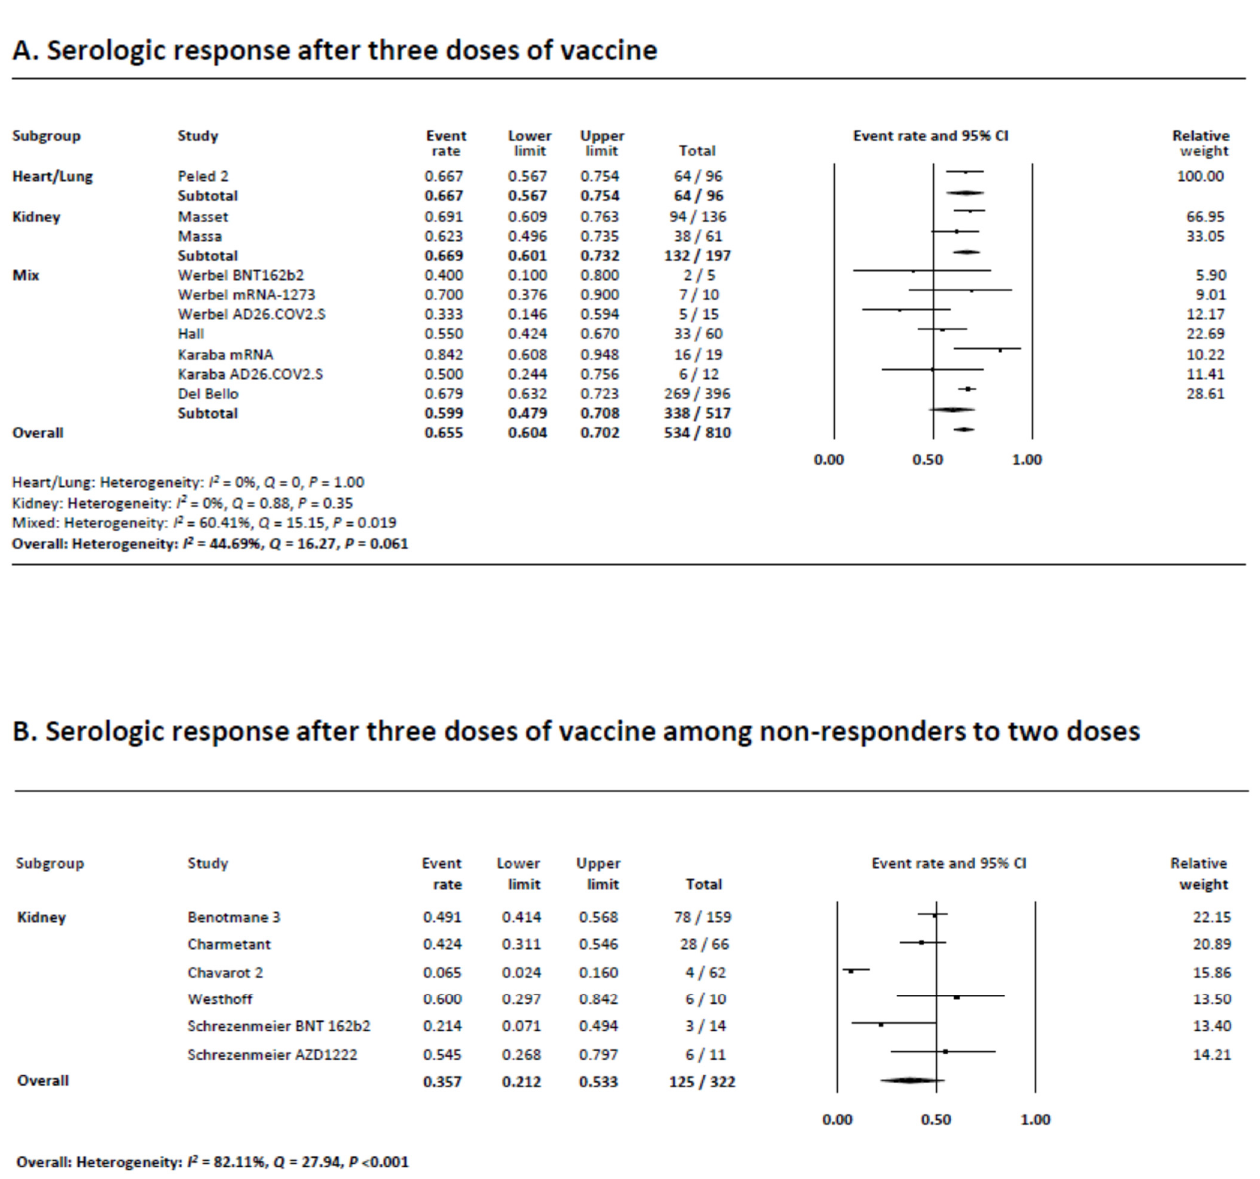
Figure 4. ( A ) Meta-analysis of serological response after three doses of vaccine. ( B ) Meta-analysis of serological response after three doses of vaccine among non-responders to two doses.